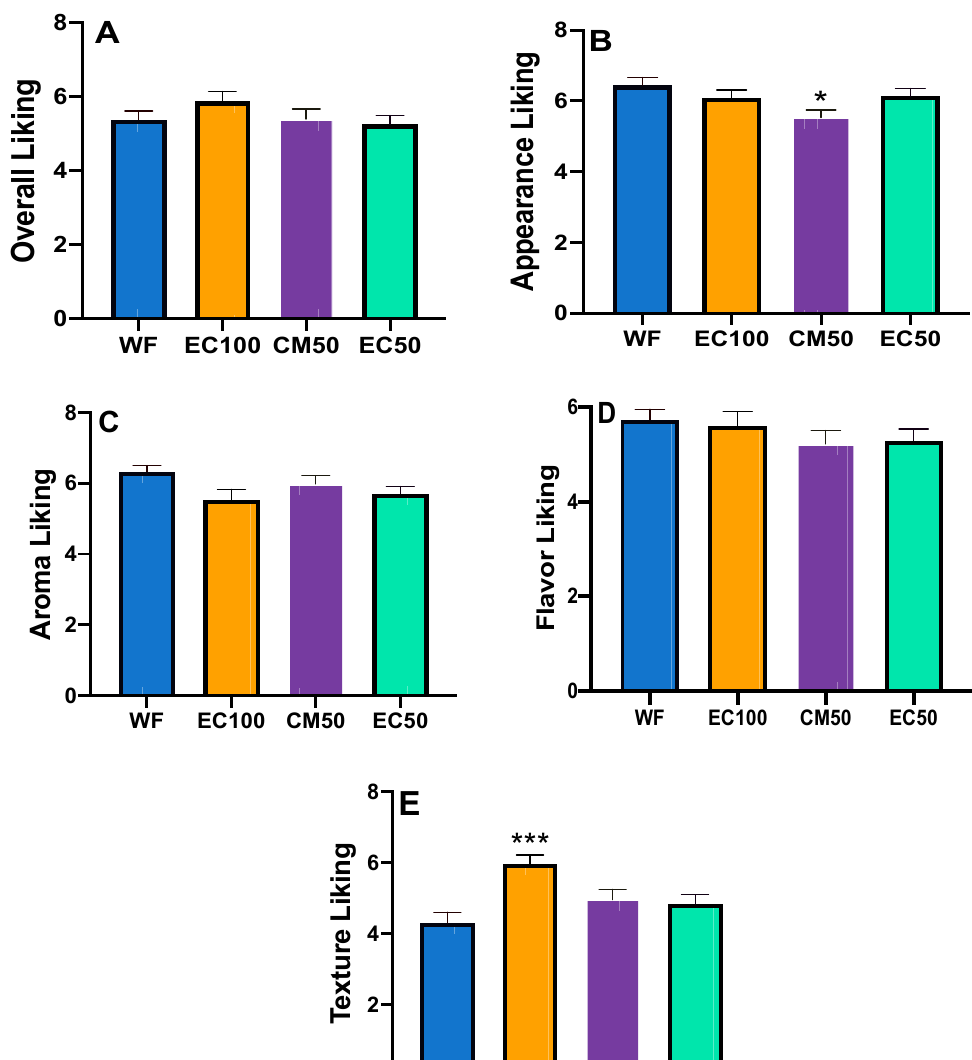
Figure 5. Hedonic scores (means ± S.E.) of whole wheat flour (WF) roti (Indian flat bread) samples fortified with encapsulated defatted Nannochloropsis oceanica (EC) and color-masked defatted Nan- nochloropsis oceanica (CM) at day 21 on ( A ) Overall liking; ( B ) Appearance liking; ( C ) Aroma liking; ( D ) Flavor liking; and ( E ) Texture liking. Means with a * denote significant difference ( p < 0.05) than the control. *** p < 0.001, n = 51.